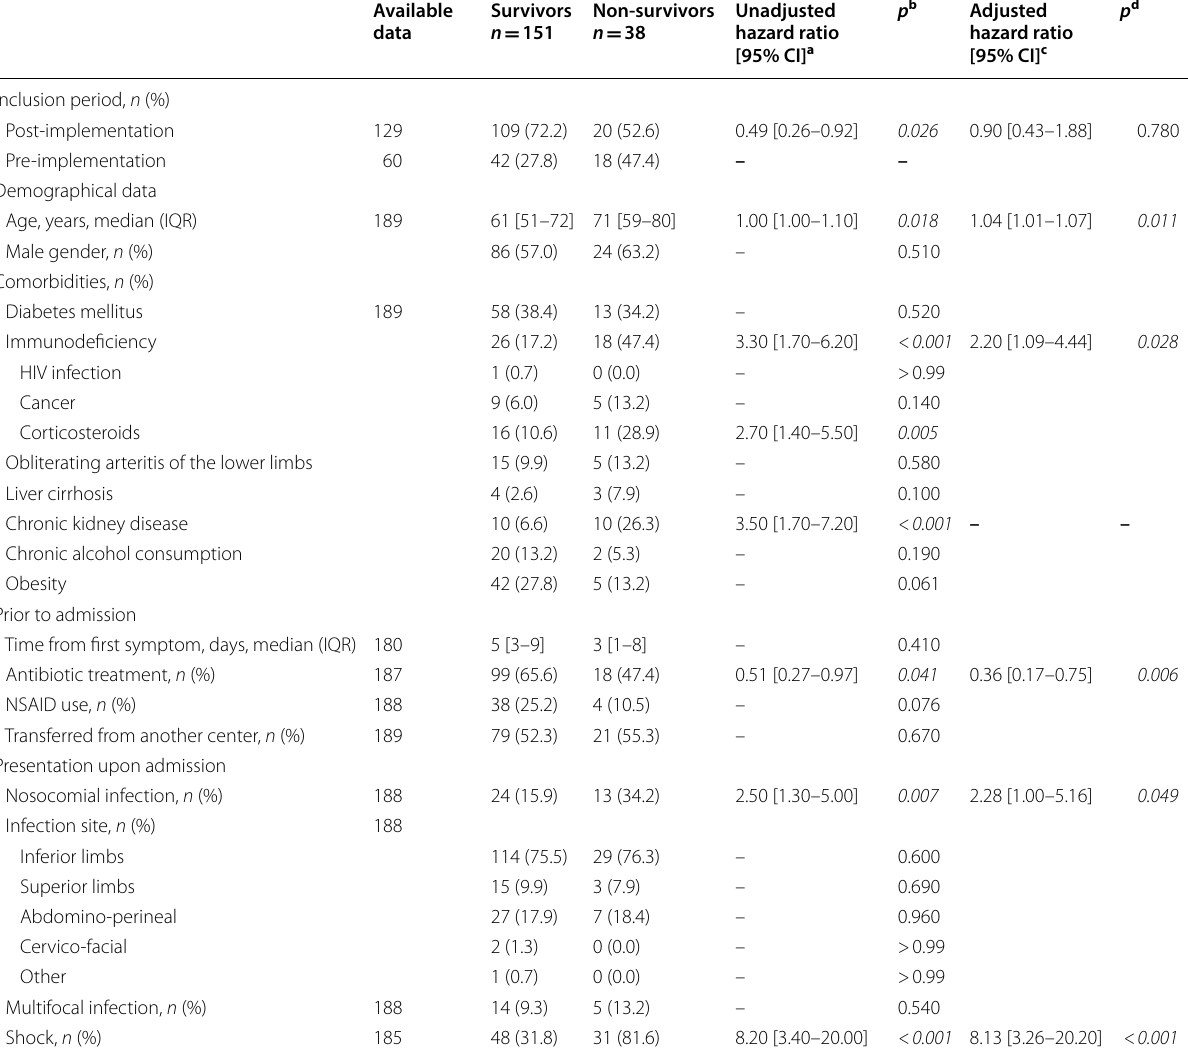
Table 2 Admission characteristics associated with hospital mortality censored at day 60 amongst patients admitted in the pre- and post-implementation